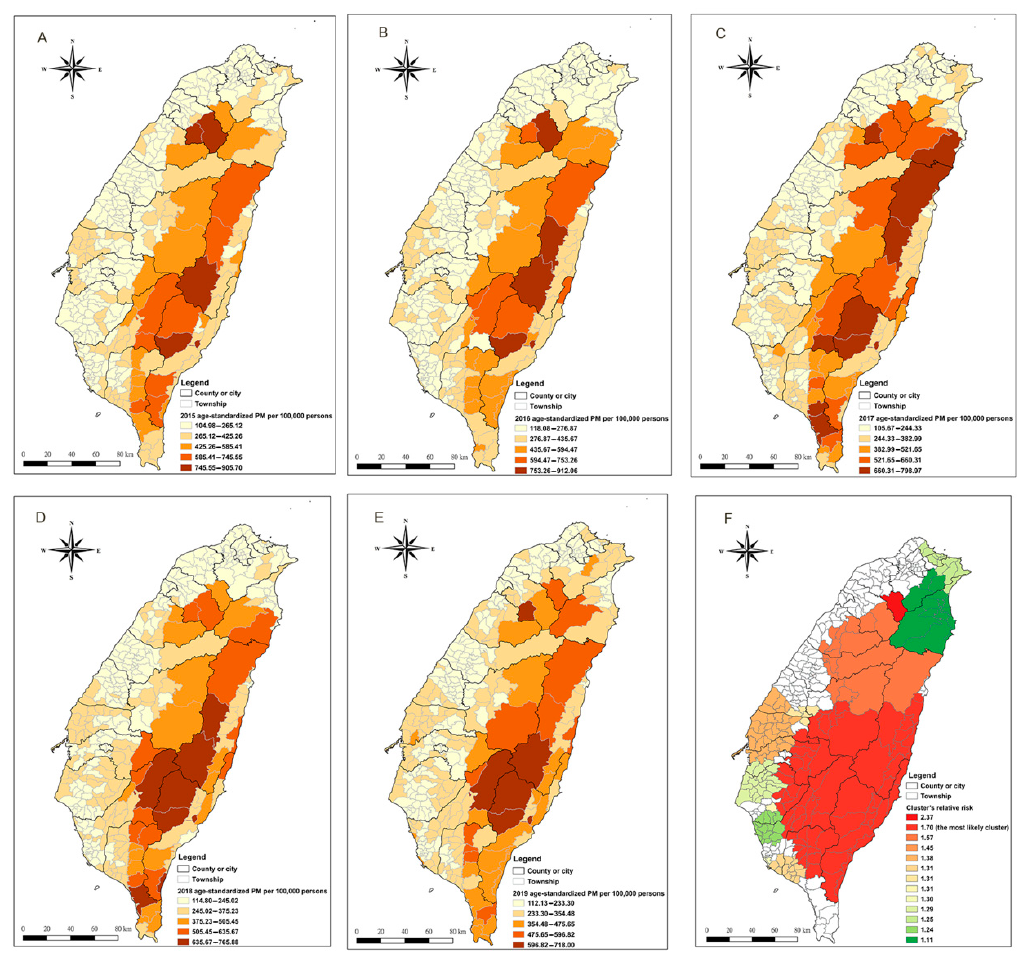
Figure 1. Geographical distribution and spatiotemporal clusters of age-standardized premature mortality. ( A – E ) Geo- graphical distribution of age-standardized premature mortality in the township level of Taiwan from 2015 to 2019. ( F ) The significant spatiotemporal clusters of premature mortality from 2015 to 2019. The black line indicates a county or city boundary. The grey line indicates the boundary of a township/neighbourhood within a county or city.